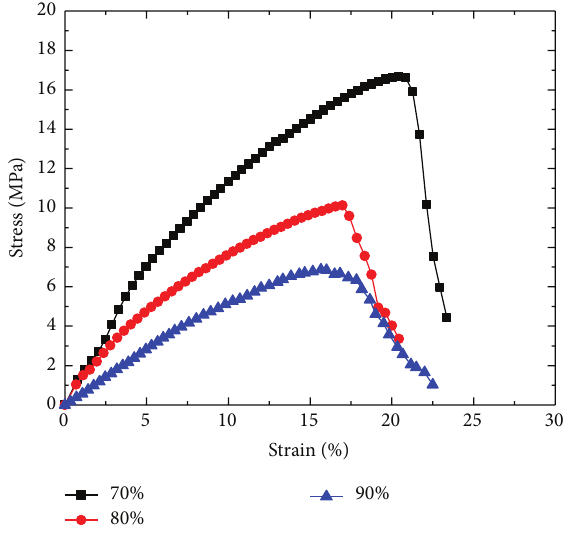
Figure 9: Tensile stress-strain curves of the oriented linear porous metal with different porosities.